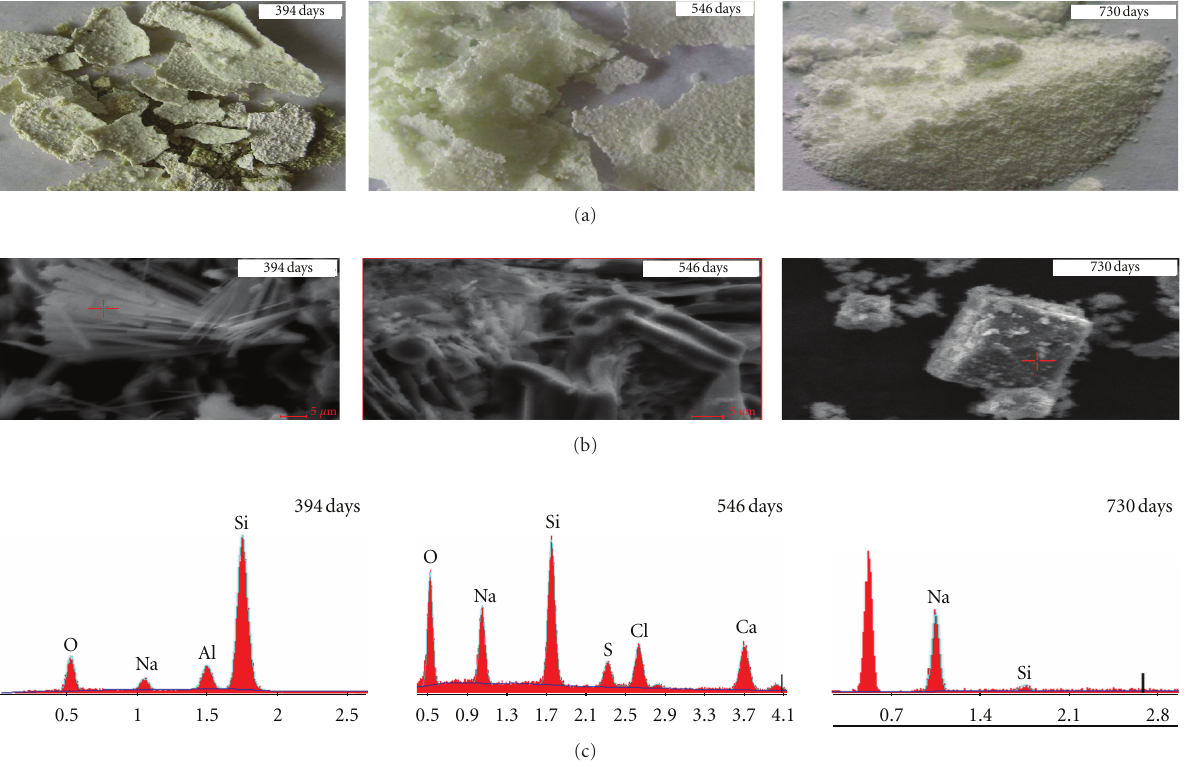
Figure 4: The secondary products (a), their SEM images (b), and their EDS (c).